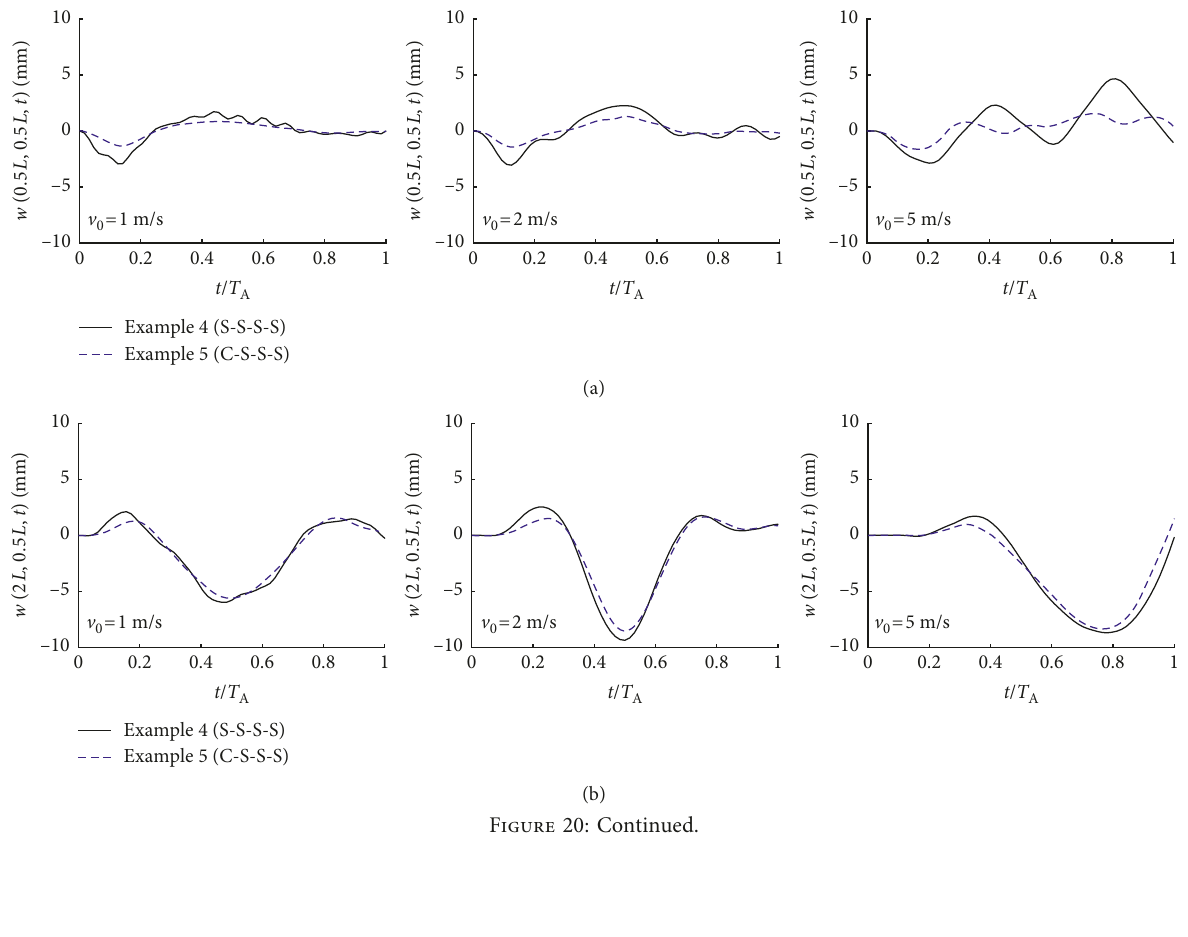
0.25 L , y 0.5 L , (b) at x (cid:31) (cid:31)